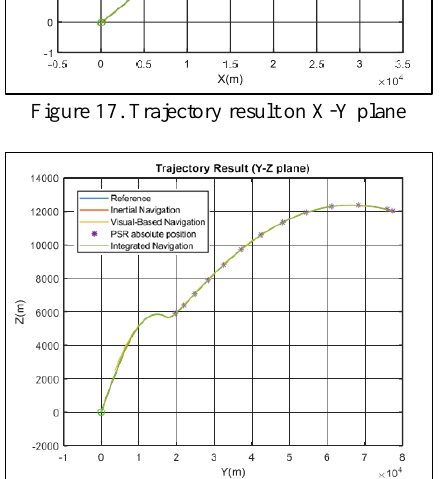
Figure 18. Trajectory result on Y-Z plane